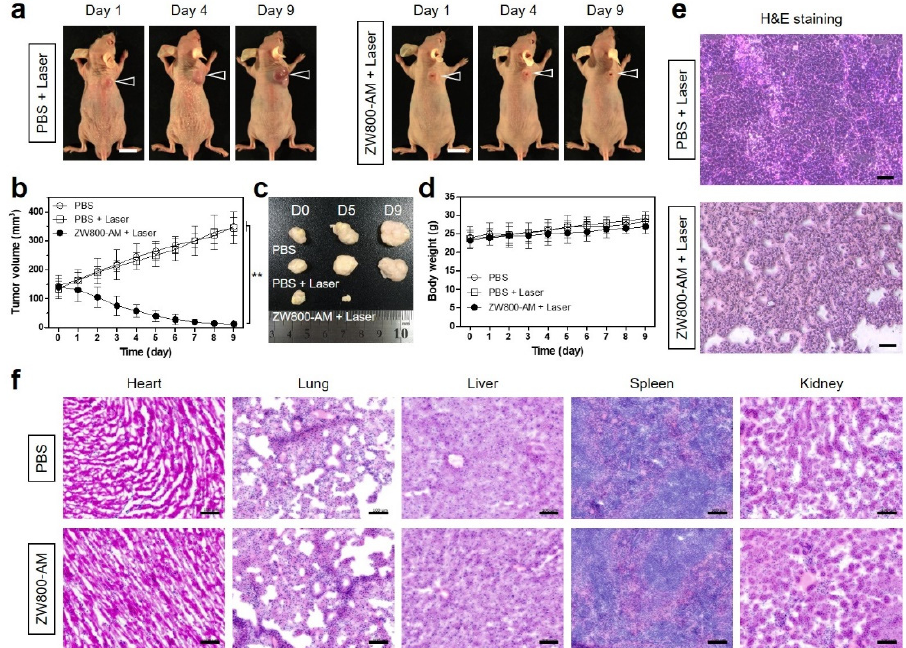
Figure 6. In vivo NIR phototherapeutic efficacy. ( a ) Representative photos of tumor size changes in NCI-H460 tumor-bearing mice over 9 days after different treatments. Laser groups are treated with 2 h post-injection of PBS and ZW800-AM, followed by 808 nm laser irradiation (1.1 W/cm 2 ) for 5 min. Tumor sites are indicated by arrowheads. Scale bars = 1 cm. ( b ) Tumor growth rates, ( c ) gross tumor photos, and ( d ) body weights of each treatment group were monitored for 9 days. Data are expressed as mean ± S.D. ( n = 3). ** p < 0.01. ( e ) Tumor sections stained with H&E from each group after 24 h of different treatments. ( f ) H&E stained images of major organs including heart, lung, liver, spleen, and kidney tissues after PBS and PTT treatments. Images are representative of three independent experiments. Scale bars = 100 μ m.